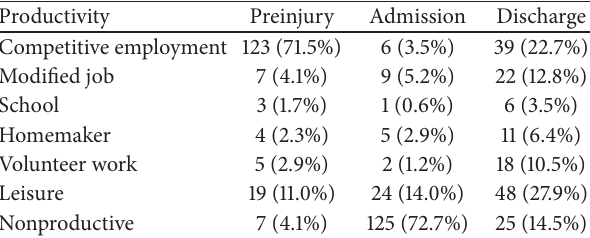
Table 3: Productivity of participants with ischemic CVA.